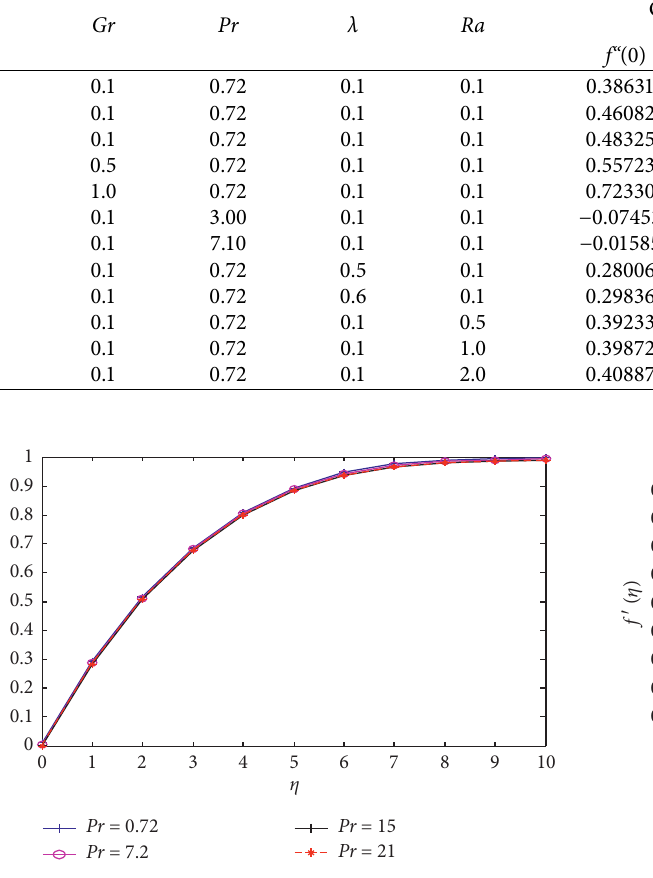
Figure 1: Velocity profiles for various values of the Prandtl number ( Pr ) when Bi � 0.1, Gr � 0.1, M � 0.1, λ � 0 . 1, and Ra � 0 . 1